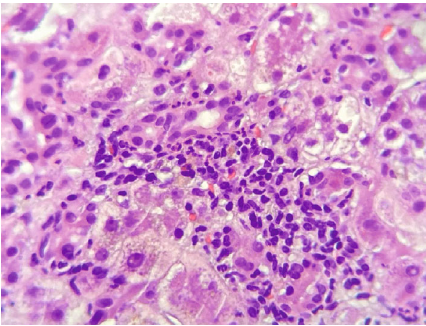
Figure 4: Cholangiolitis. Presence of polymorphonuclear intraepithelial leukocytes in the bile duct (400x, H&E staining). Source: own . Figure 2: Ballooning degeneration. Note swollen hepatocytes with